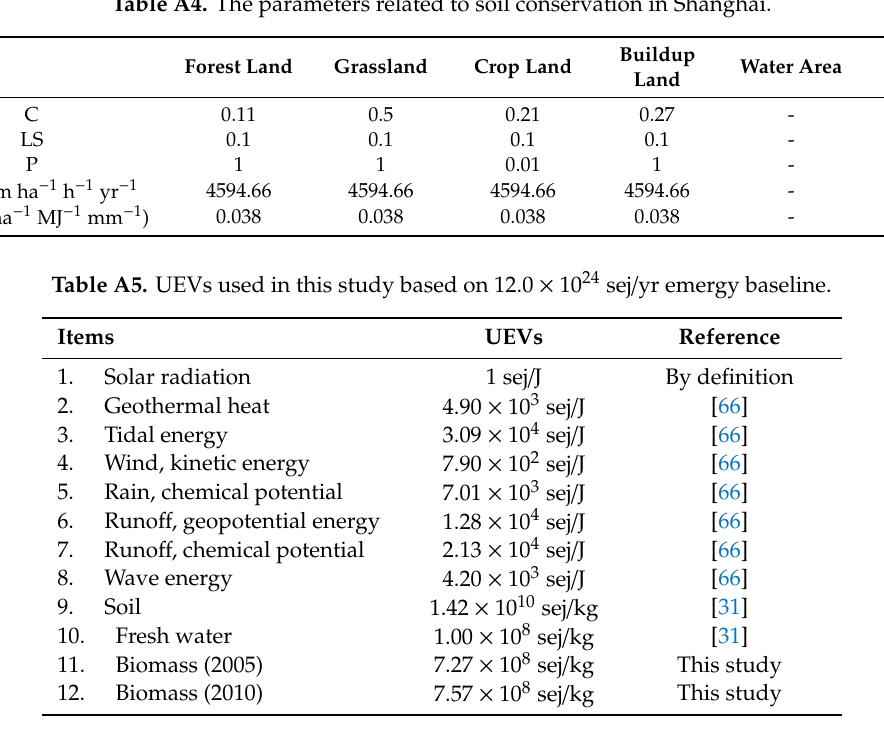
Table A4. The parameters related to soil conservation in Shanghai.